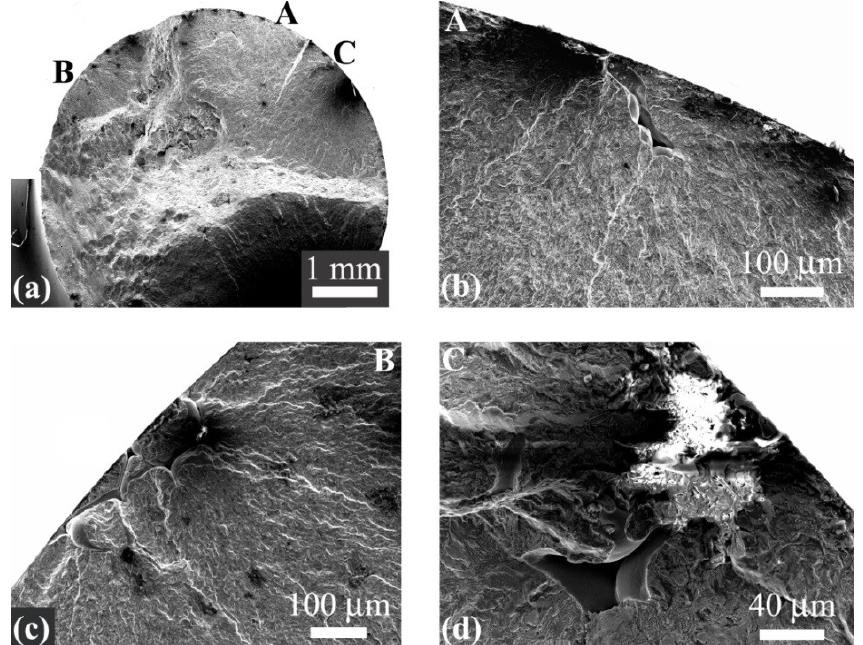
Figure 5. SEM images of the fracture surface for the hourglass specimen with multi-site crack initiation, local stress amplitude σ a = 315 MPa, N = 7.96 × 10 4 . ( a ): Fracture surface with low magnification; ( b – d ): close-ups of crack initiation regions A, B, and C in ( a ).